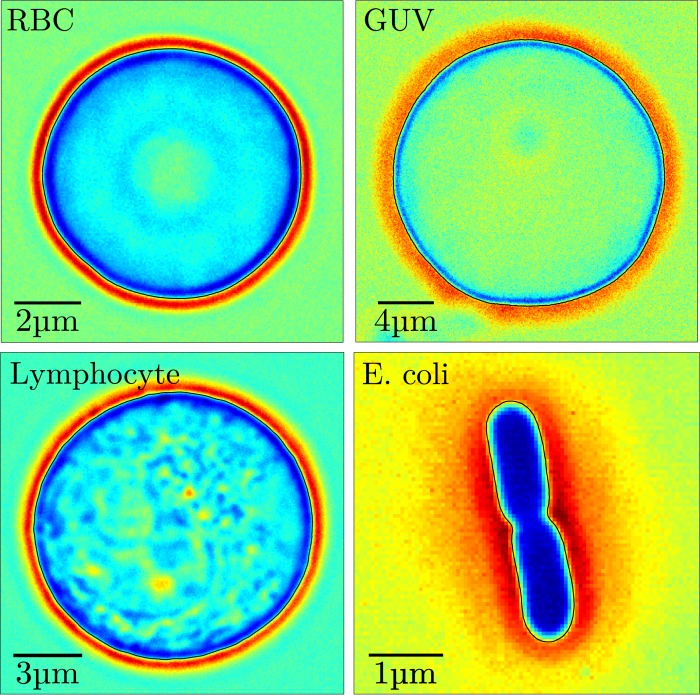
Examples of microscopic objects that have successfully been tracked using our new segmentation algorithm.The obtained contour is indicated by the black line that is overlaid on each image. All images were recorded with bright-field light-microscopy, except for the E. coli, which was recorded using a phase-contrast objective (100x, NA1.45).